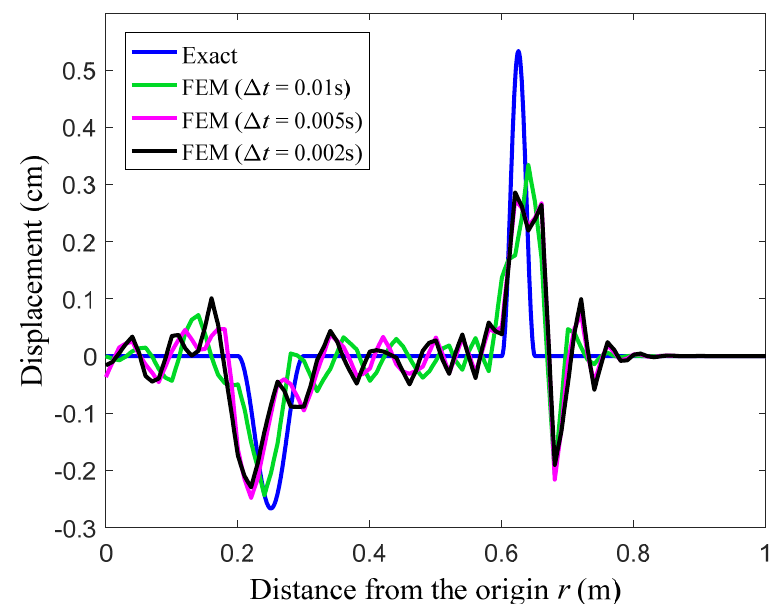
Figure 8. The displacement solutions from the conventional FEM for the elastic bar.